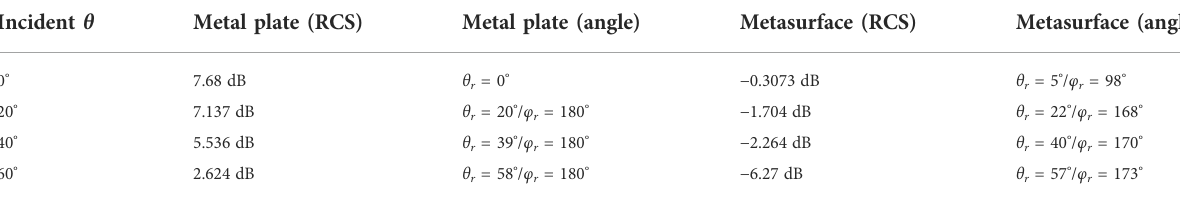
TABLE 3 Value and angle of max RCS of the metal plate and metasurface in different incident angles θ